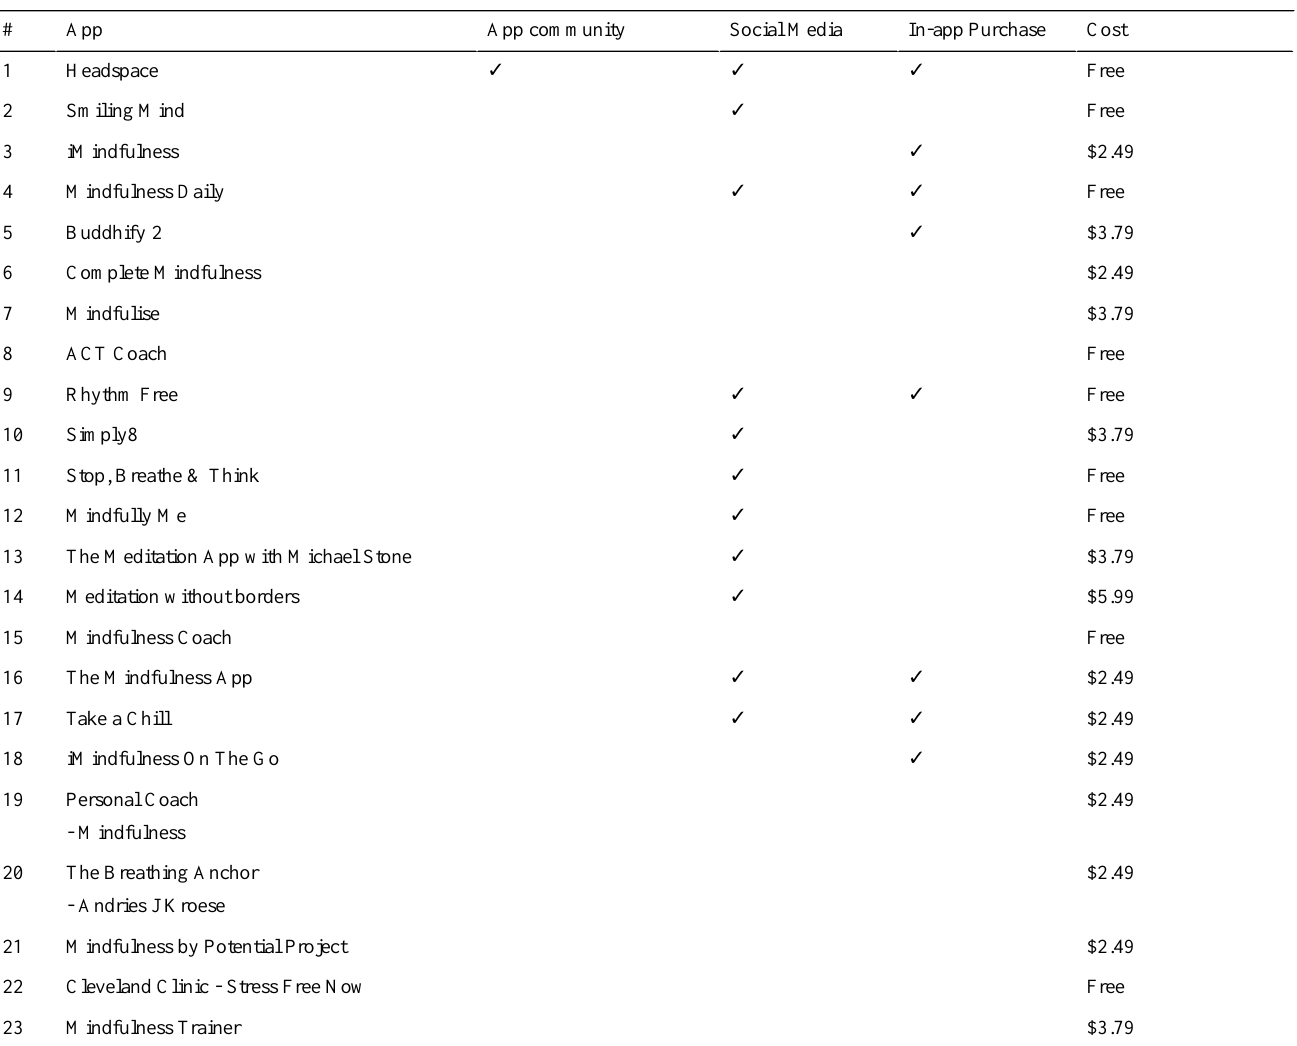
Table 3. Summary of mindfulness-based app